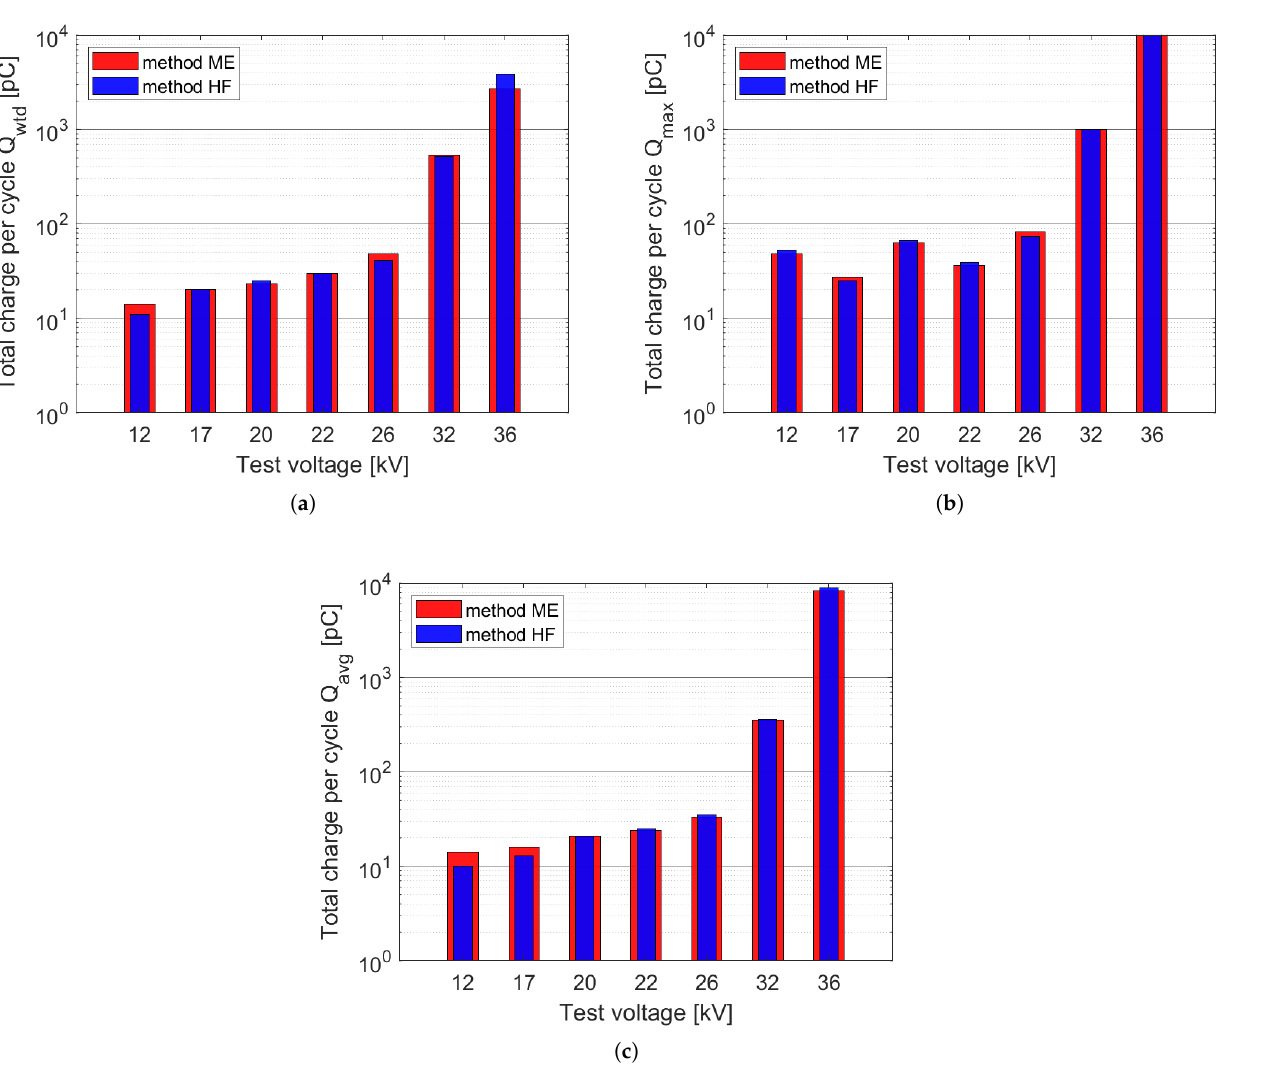
Figure 9. Graphical presentation of the value of Q depending on the U p for a cable without installed corona rings, registered with the ME and HF method: ( a ) Q wtd , ( b ) Q peak , ( c ) Q avg